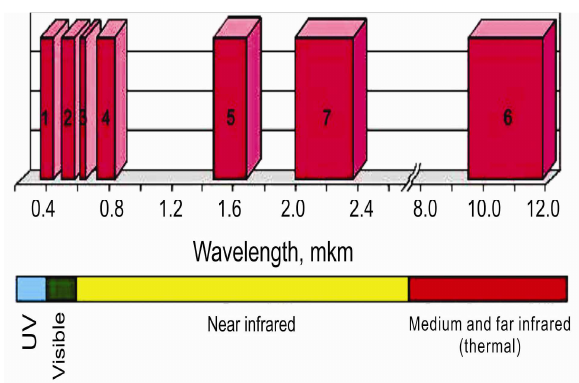
Figure 1. Spectral characteristics of the Landsat system